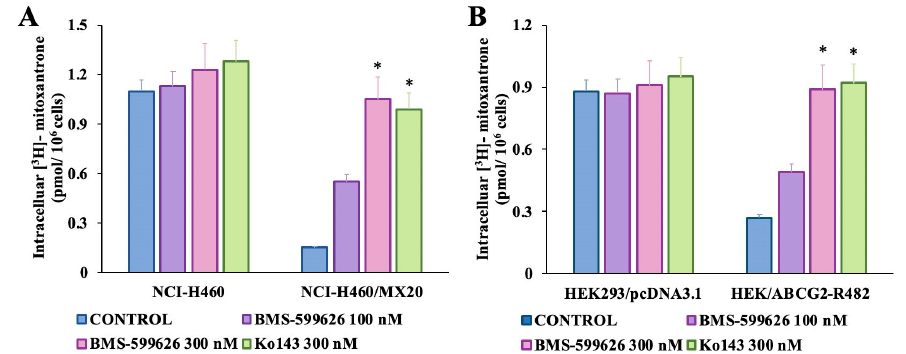
Figure 4. Effect of BMS-599626 on the intracellular accumulation of [ 3 H]-mitoxantrone in parental cells cells overexpressing wild type and mutant ABCG2. Effect of BMS-599626 on the intracellular accumulation of [ 3 H]-mitoxantrone in ( A ) NCI-H460 and NCI-H460 / MX20 cells and ( B ) HEK293 / pcDNA3.1 and HEK / ABCG2-R482 cells. Mean values from three independent experiments are given and error bars indicate SD. (*) indicates p < 0.05 compared to the control group.